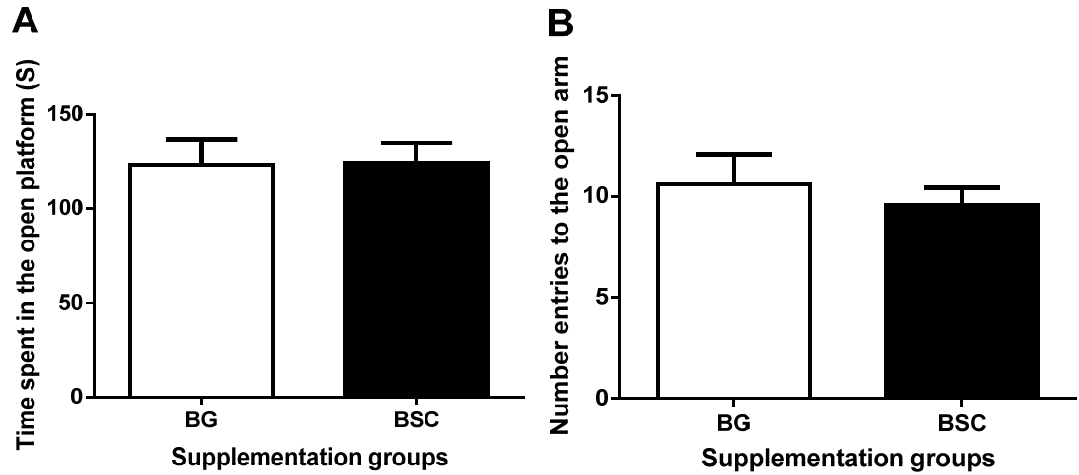
Figure 5. The time spent in ( A ) and the number of entries to ( B ) the open arms of Elevated Plus Maze were similar between the groups with (closed bars) and without (open bars) the supplementation. The data are presented as mean ± SEM, n = 16, BG = blank